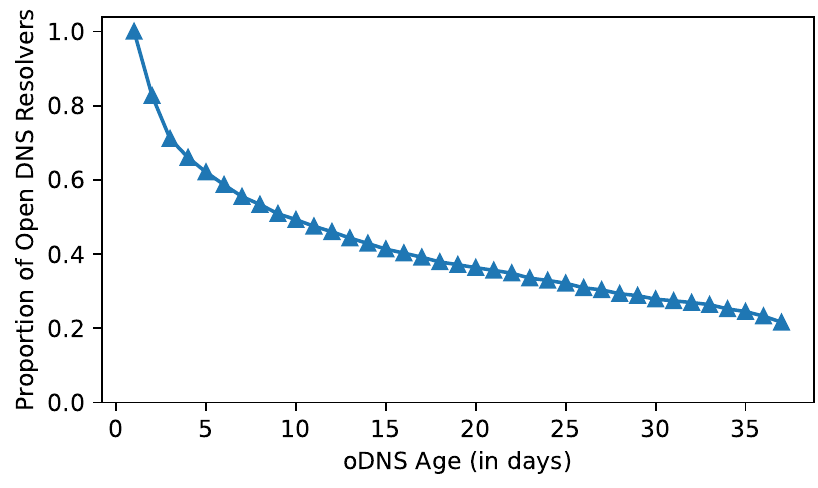
Figure 3. IP address churn of DNS resolvers for 30